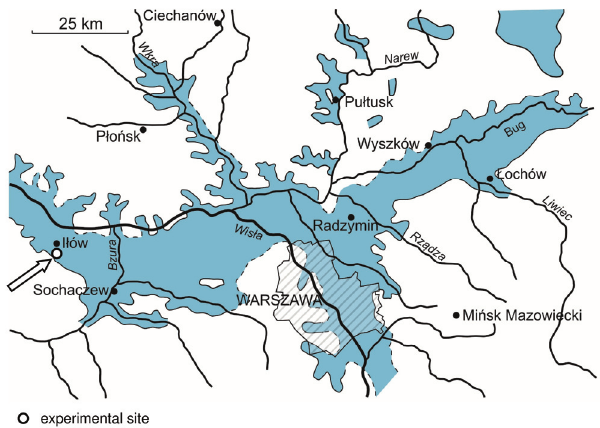
Fig. 1. Warsaw Ice-Dammed Lake (blue) after Różycki